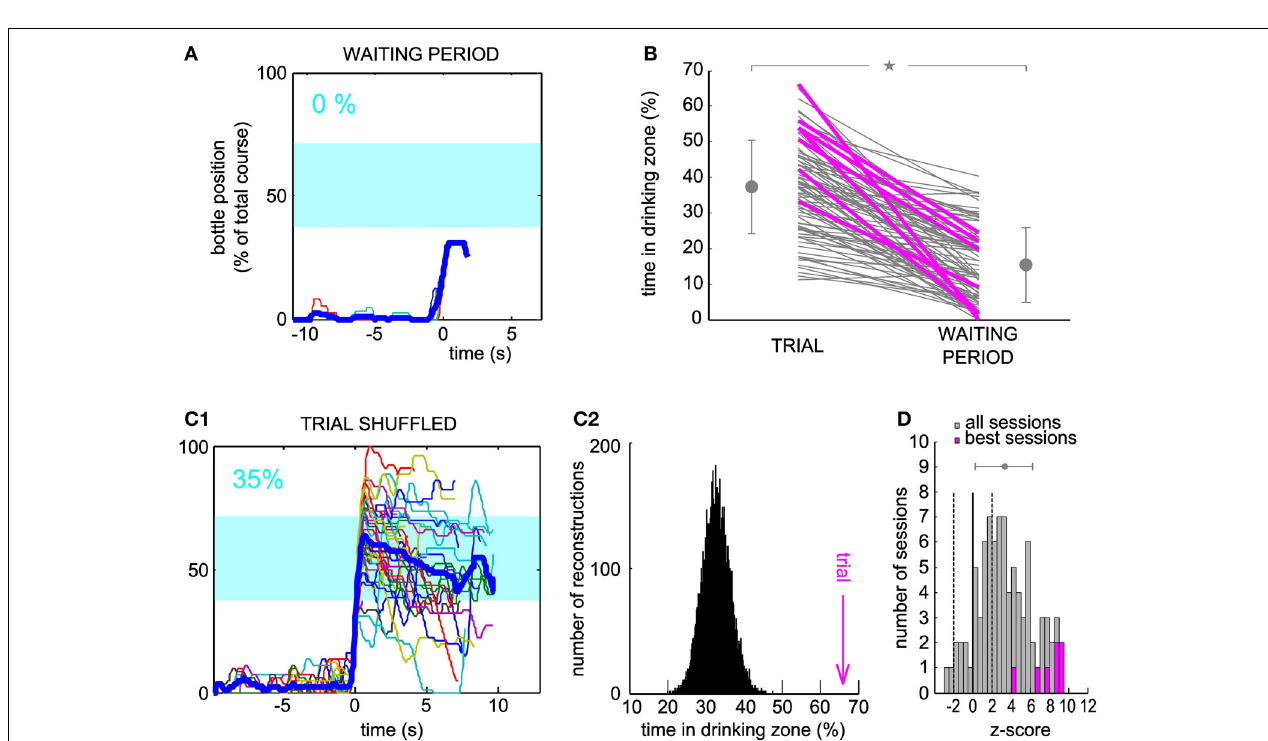
FIGURE 3 | Neuronal control of the bottle resulted in a higher task performance than in control datasets. (A) Superposition of all reconstructed trajectories for the same conditioned neuron and the same session as Figure 2D , centered in time on the position y = 20% for clarity, if the bottle reached that position (11% of the trials only, the rest was not plotted), using the waiting period activity as an input to the neuronal control algorithm. The percentage of total trial time spent in the drinking zone is displayed in the upper left corner in blue. (B) Percentage of time spent in the drinking zone for the trial datasets and the waiting period (control) datasets. Each line joins the two values calculated for a conditioned neuron during one session. Magenta lines are the best sessions (one per neuron). The mean ± SD are indicated on each side of